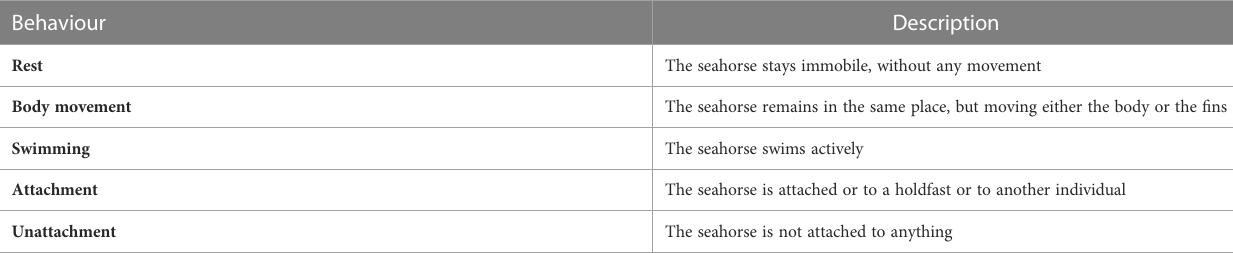
TABLE 1 Ethogram of Hippocampus guttulatus describing activity patterns and holdfast attachment (adapted from Faleiro et al., 2008).